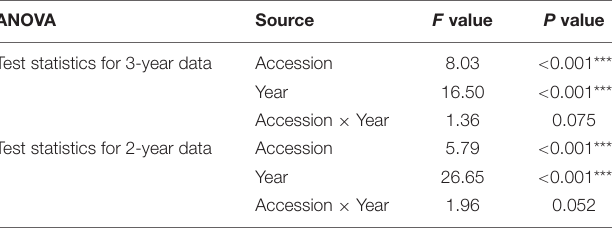
TABLE 1 | Two-way ANOVA results of selected accessions including the varieties “Hybnos,” “MV Emese,” “MV Regiment,” “Mv Dalma,” and “Mv Vekni” tested in 2 years and 3 years, respectively, showing the effect of accession, year and interaction on the WDV infection rate.